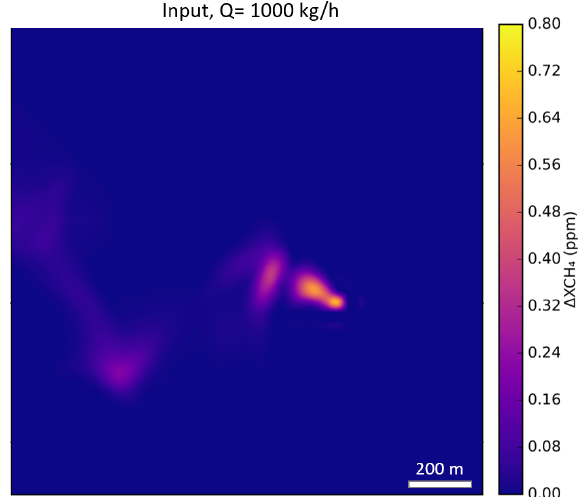
Figure 4. Methane column mixing ratios for an example simulated plume with Q 1000kgh − 1 used as a reference over the same subset of 1.5 × 1.5km 2 shown in the bottom row of Figs. 5, 6, and